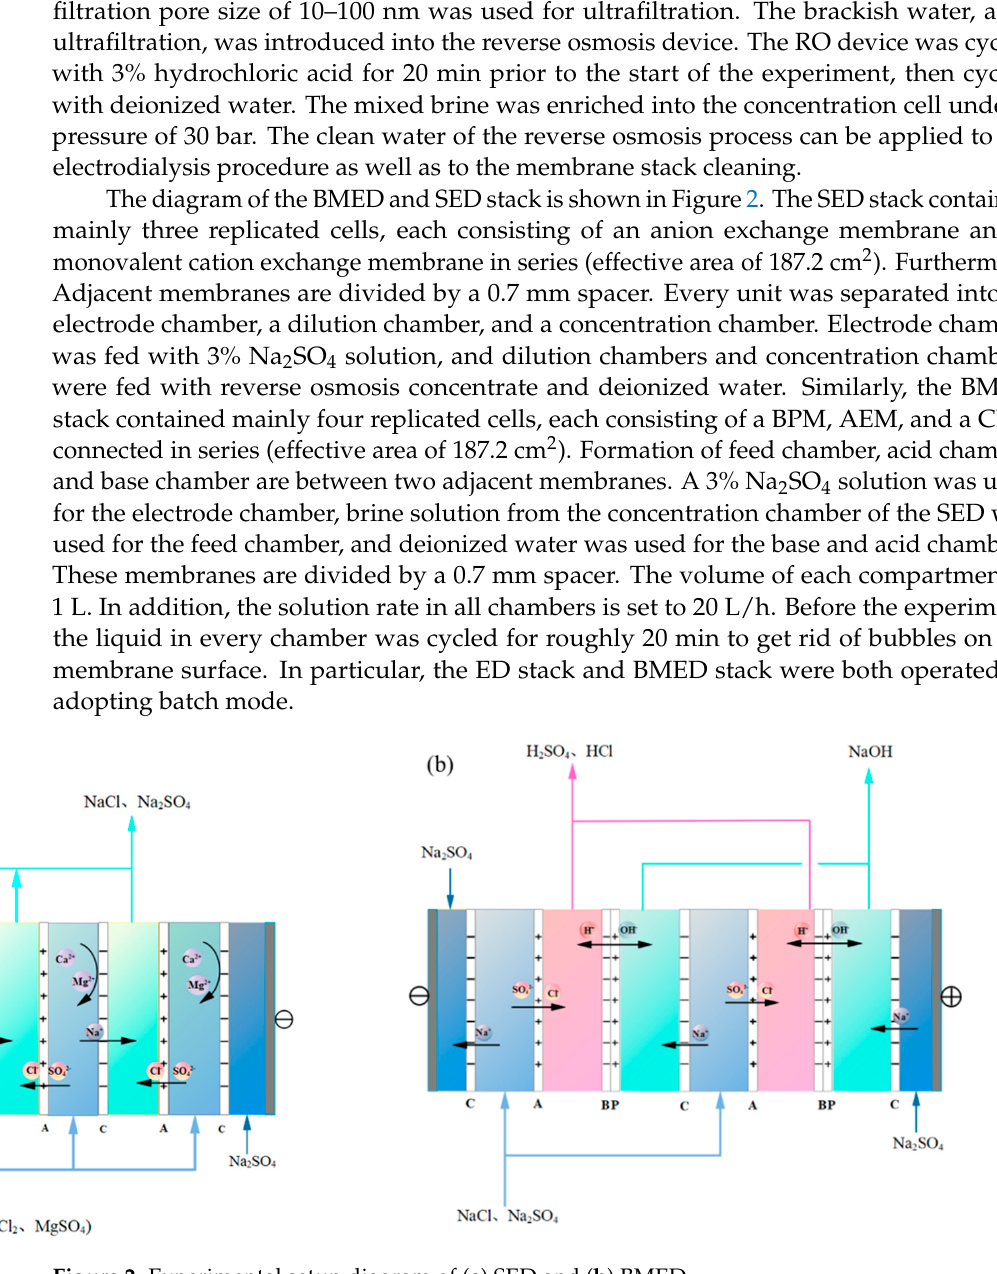
Figure 2. Experimental setup diagram of ( a ) SED and ( b )